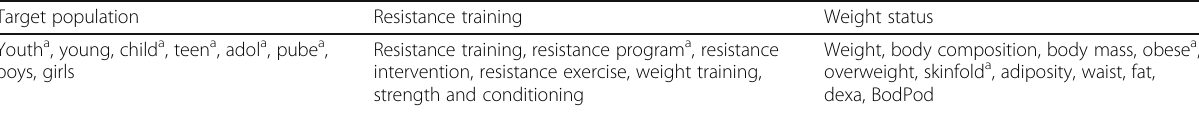
Table 1 Systematic review categories and search terms Target